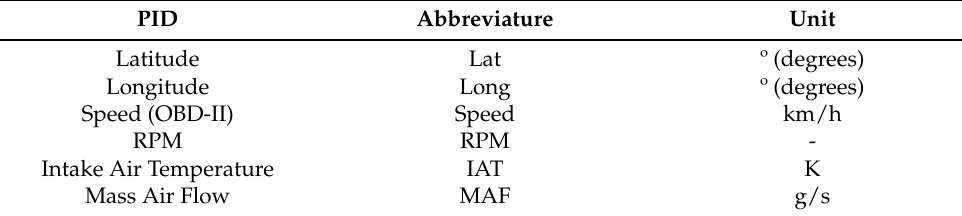
Table 4. Data collected from sensors by the Freematics ONE+ unit. PID Abbreviature Unit Latitude Lat º (degrees) Longitude Long Speed (OBD-II) Speed km/h RPM RPM - Intake Air Temperature IAT K MAF